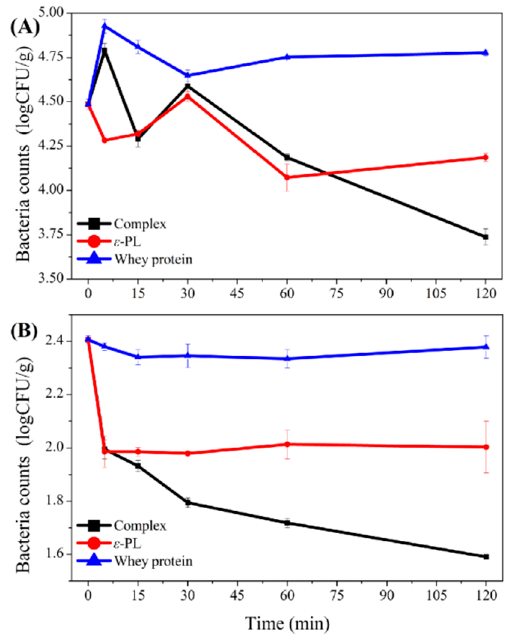
Figure 7. Bactericidal effect over time of whey protein- ε -PL complexes, ε -PL, and whey protein on ( A ) total mesophilic and ( B ) native Staphylococcus aureus counts in fresh meat.